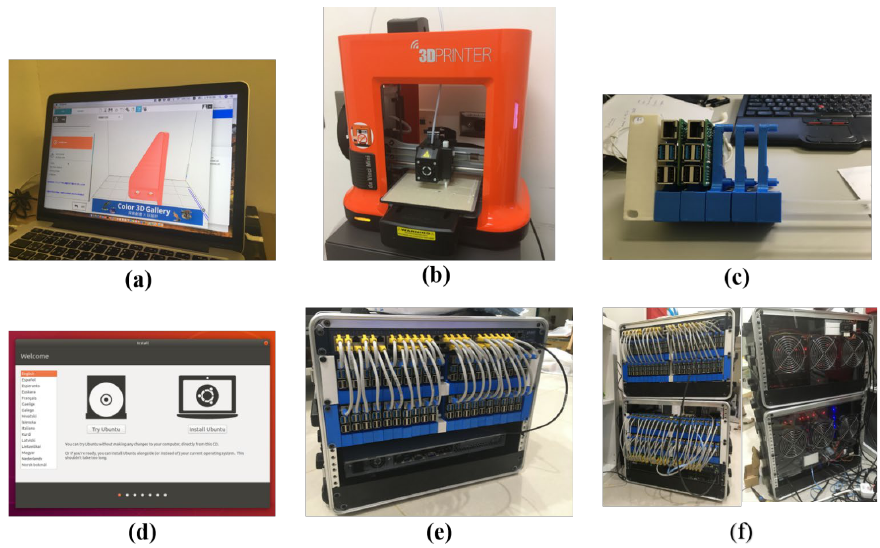
Figure 2. Assembly process of hardware. ( a ) The 3D standard tessellation language file for printing. ( b ) The 3D printer for the study. ( c ) The printed Pi SBC holder. ( d ) Cluster software installation. ( e ) Version 1 of the cluster. ( f ) The final version of the cluster with 8U and 6U rack boxes.